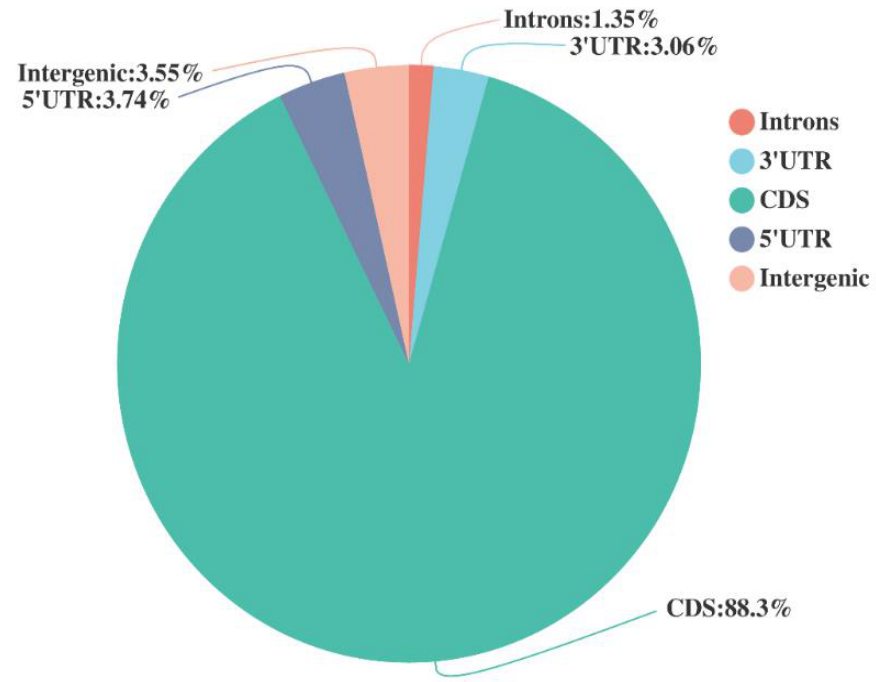
Figure 1. Pie charts showing the percentage of different repeated elements identified in wheat genome of collected samples. The most abundant components identified were CDS, intergenic, introns, and 3 ’ UTR: 3.06% followed by 5 ’ UTR.